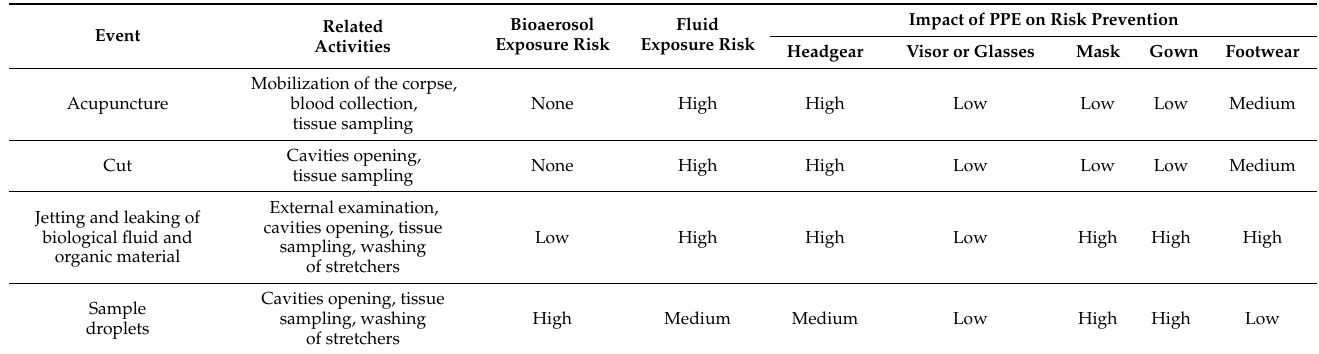
Table 5. Risk analysis of necropsy activities and impact of PPE in preventing